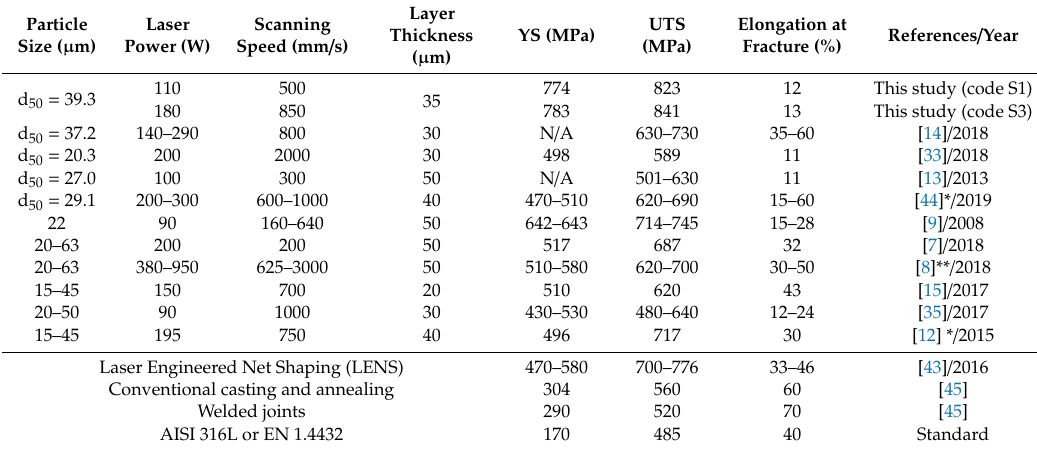
Table 5. Comparison regarding the obtained mechanical properties of SLM-manufactured samples from 316L powder in as-build